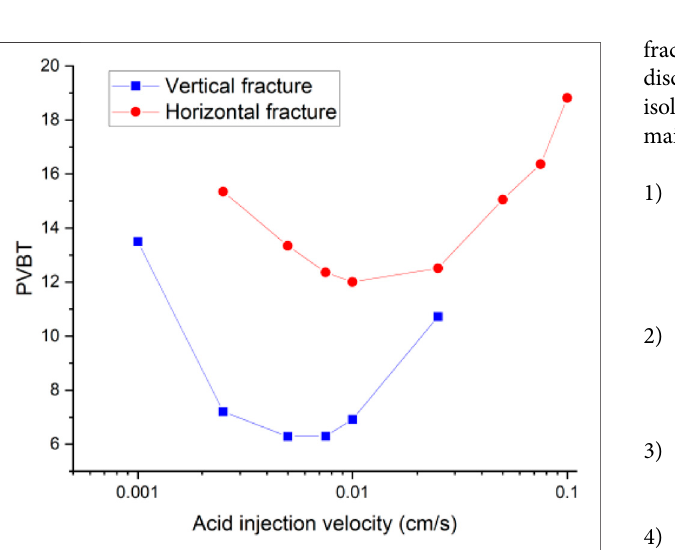
FIGURE12| Isolatedfractureacidizingcurvesofporevolumetobreakthrough.